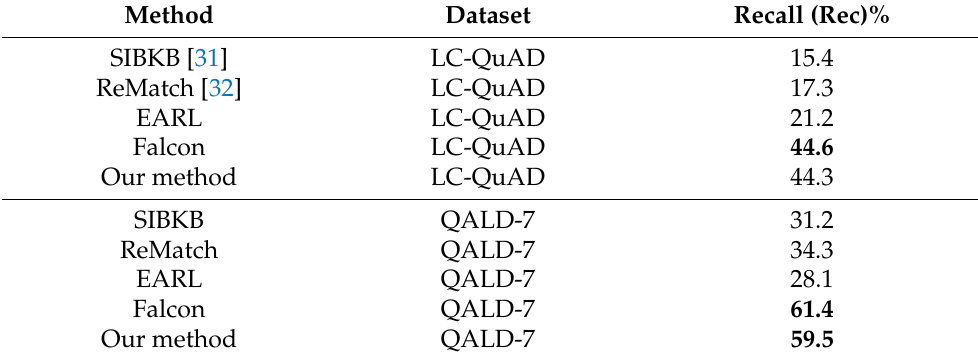
Table 3. Performance of our method compared to various relation-linking tools.